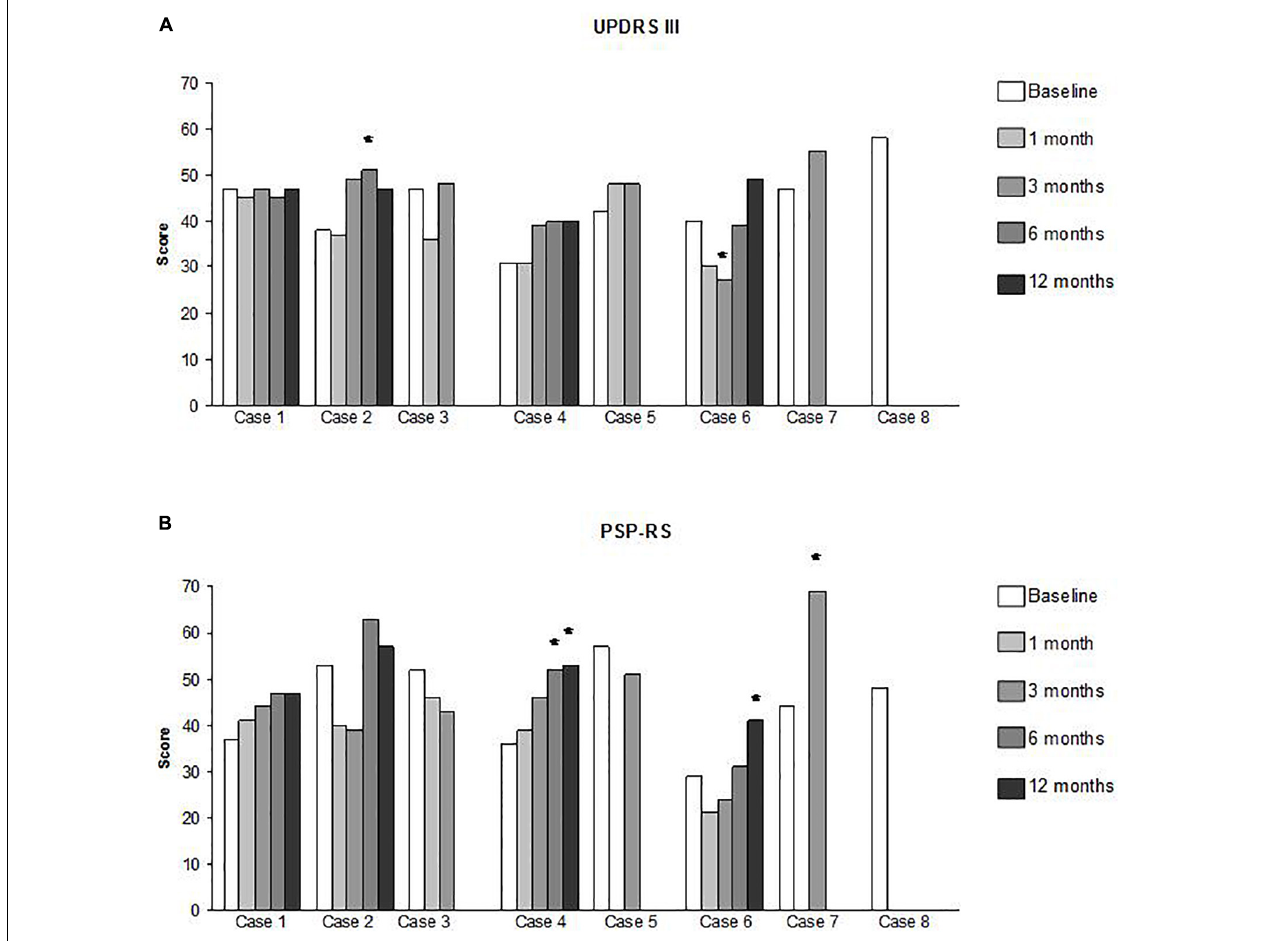
FIGURE 2 | Clinical assessments data per single patient and at each time point. (A) UPDRS III (Unified Parkinson’s Disease Rating Scale part III, motor score); (B) PSP – RS (PSP Rating Scale). The star symbol (*) identifies those measures that overcome the stabilization threshold as defined in the